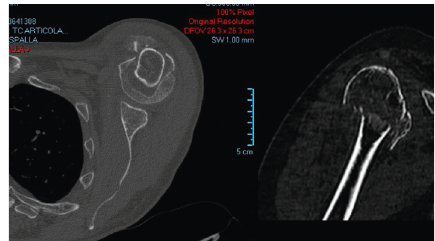
Figure 2: CT scan layer of a PHF in axial and frontal planes.